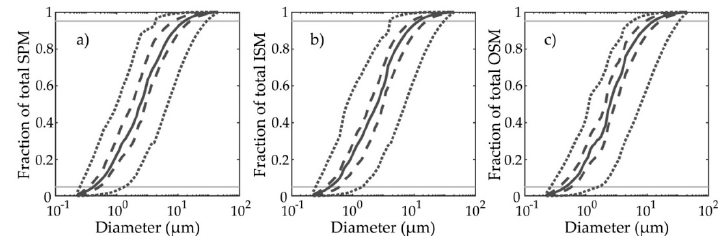
Figure 6. Cumulative distributions of modelled ( a ) SPM, ( b ) ISM, and ( c ) OSM values for the fractal volume model. The SPM curves refer to SPM values calculated from the total PSD. Solid, dashed, and dotted lines represent median, upper/lower quartiles, and maximum/minimum values respectively. The light grey horizontal lines mark the middle 90% of the contribution (i.e., from 5% to 95%) to the total value of each parameter.